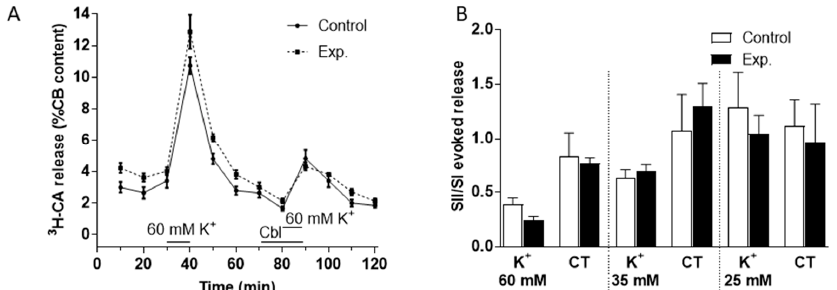
Figure 3. Mean effects of 300 µM Cbl on the ratio of the second and first 3 H-CA responses to hypoxia shown in Figure 2. Results were calculated separately for 3 H-CA release during hypoxia and during the subsequent 20 min of normoxia (Nx) during which release fell back to the baseline. ( A )–( C ) Mean effects of Cbl on the ratio of the second and first responses to hypoxia for 2, 5, and 7% O 2 ; Cbl was present for 10 min before and during the second hypoxic period. ( D ) Mean effects of Cbl on the ratio of the second and first responses to hypoxia for 2% O 2 ; Cbl was present for 10 min before and during the second hypoxic period, as well as during the subsequent 20 min of normoxia. Asterisks indicate where there was a significant effect of Cbl. Number of replicates for each condition as is indicated in Figure 2.